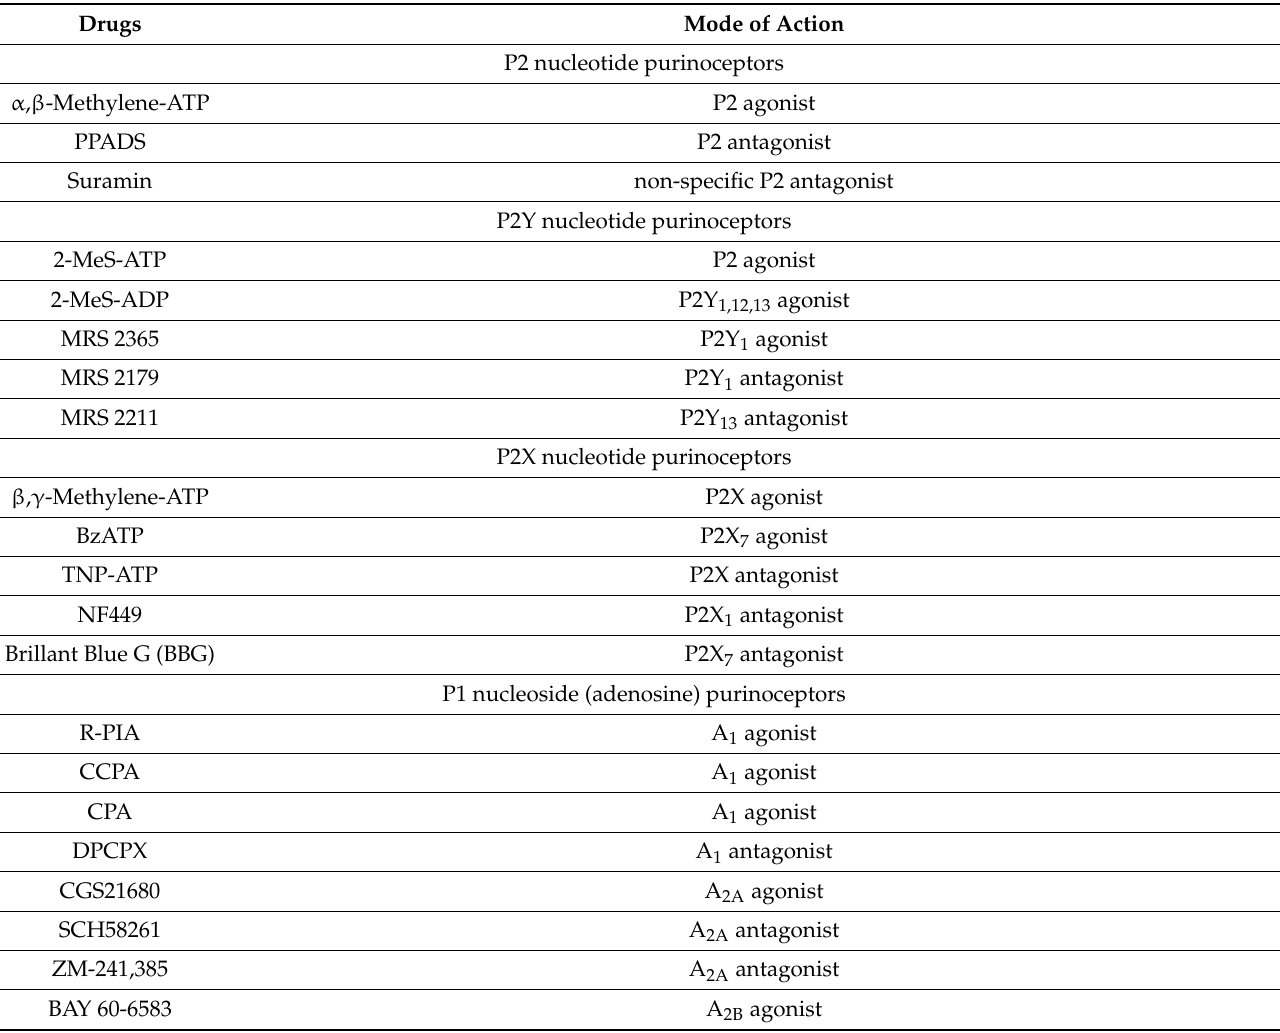
Table 1. Drugs used to investigate purinoceptors in neurodegenerative–neuroinflammatory disorders of the central nervous system and